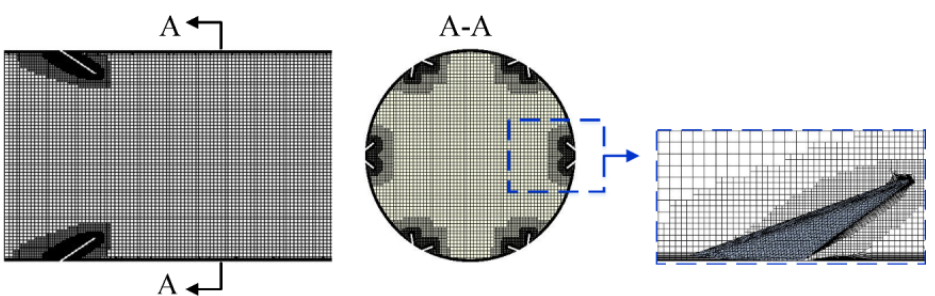
Figure 4. The grids generated of PR = 1.5, RA = 30 ◦ . As illustrated in Figure 5, four different grid sizes were checked off: PR = 1.5, RA = 10 ◦ with 3 million, 7 million, 11 million and 19 million at Re = 9090, respectively. The number of grids increased from 11,220,383 to 19,119,226 and the maximum deviations of Nu and f were 0.012% and 0.16%, respectively. Therefore, the grid system with 11,220,383 was selected for subsequent